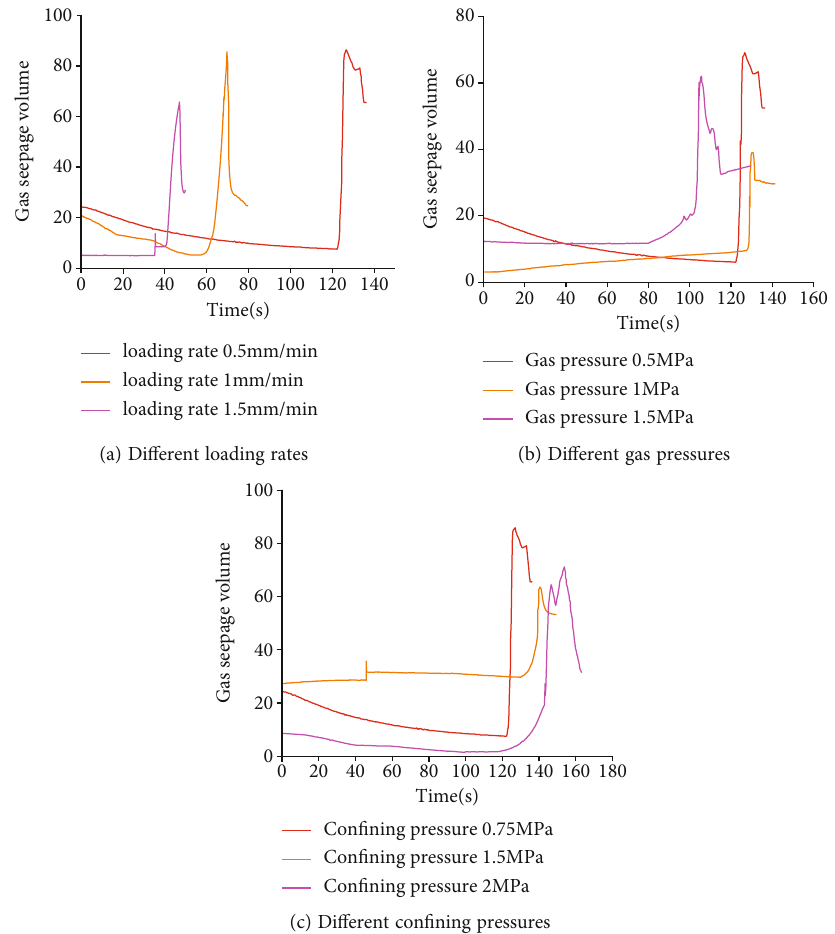
Figure 4: Time-gas seepage volume curve under di ff erent loading